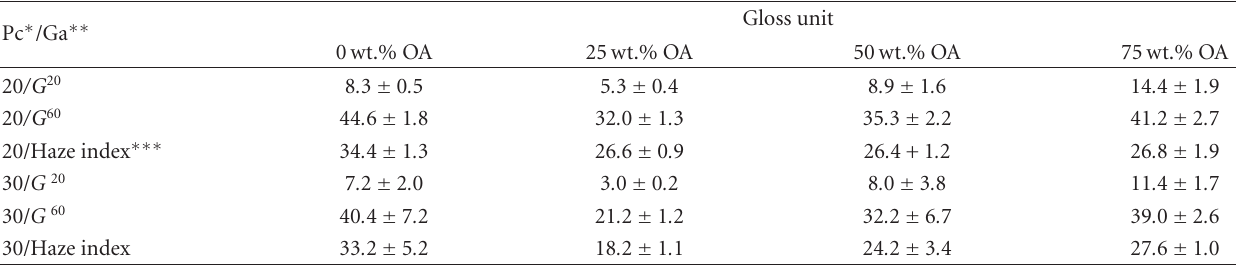
Table 3: Gloss value and haze index of the laminated paperboard.